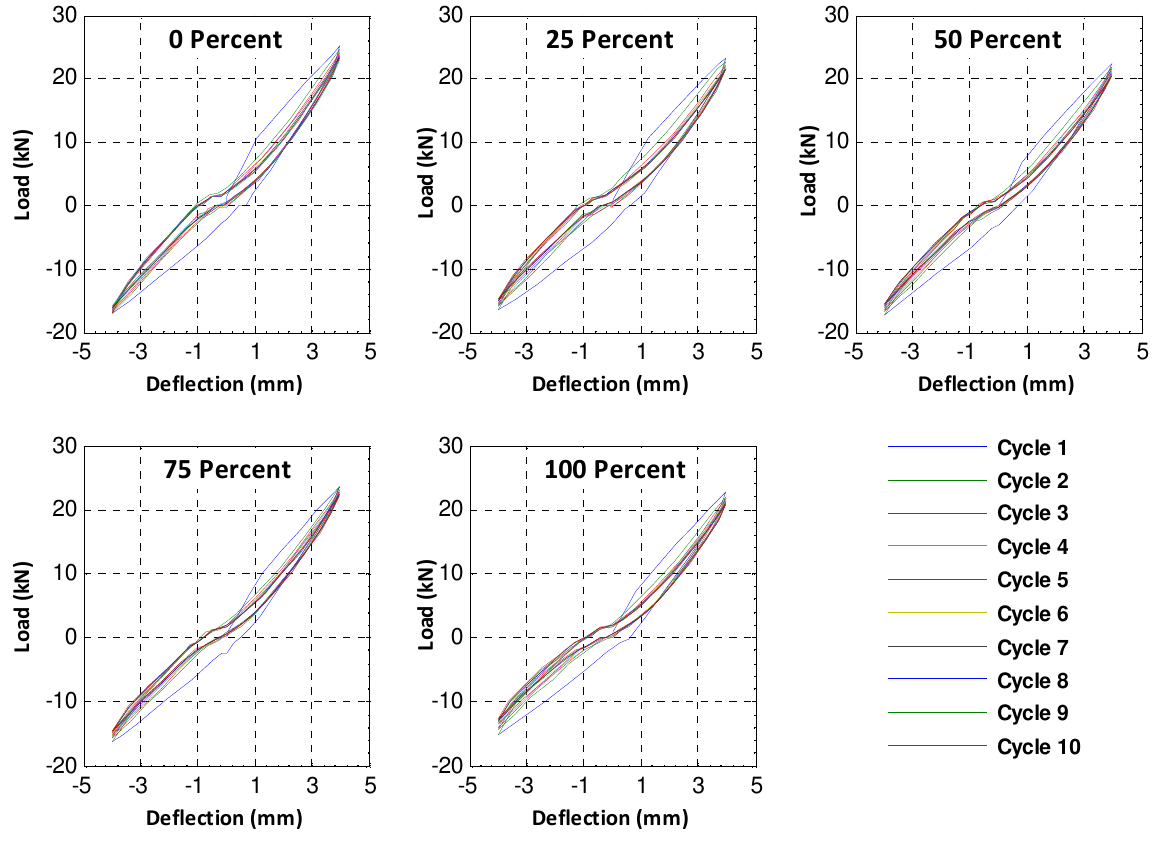
Fig.7: Hysteresis loops (loading cycles of 4 mm